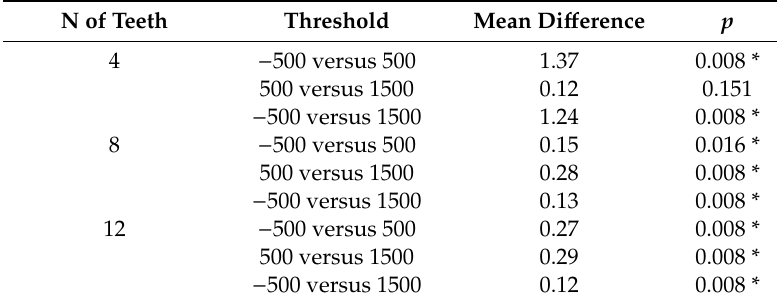
Table 2. Pairwise comparison of registration error between di ff erent thresholds of gray value using the